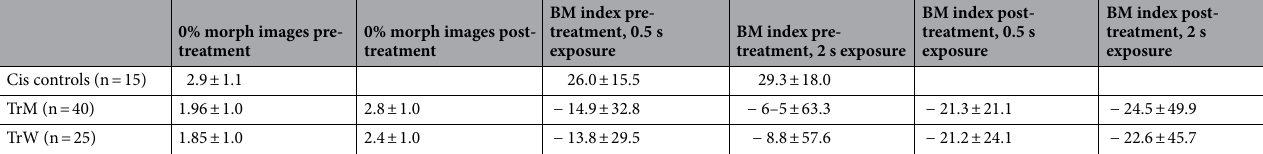
Table 2. Results from the BM test. Ratings for 0% morphed (unaltered) images ranged from 0 (not me at all) to 4 (entirely me). Positive values on the BM index indicate greater self-identification with their body morphed to other bodies that are the same as their birth assigned sex (as seen in cis-controls); negative values indicate greater self-identification with their body morphed to other bodies that are the opposite to their birth